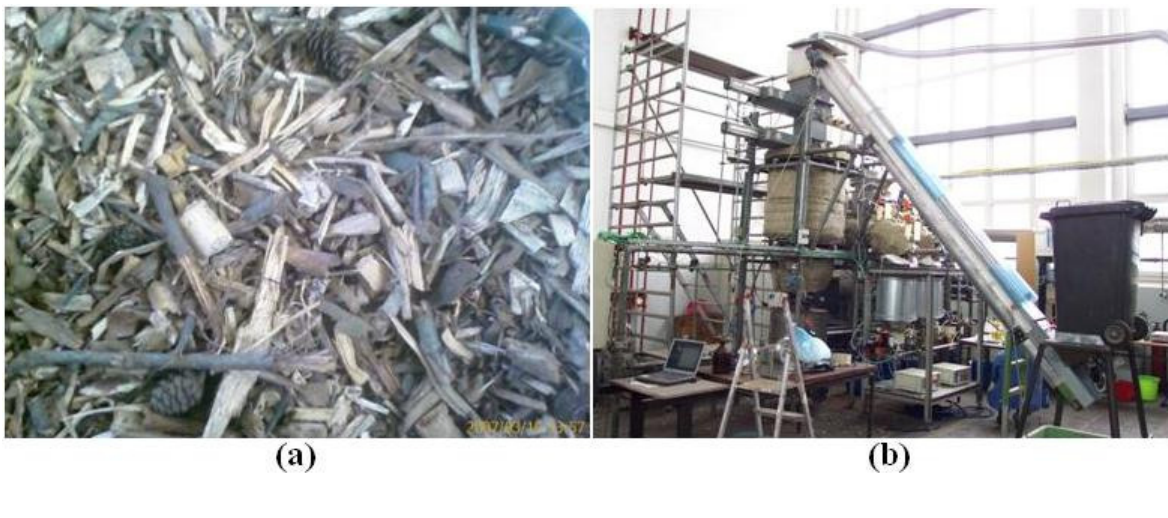
Figure 1. ( a ) Biomass fuel for gasification; and ( b ) Updraft